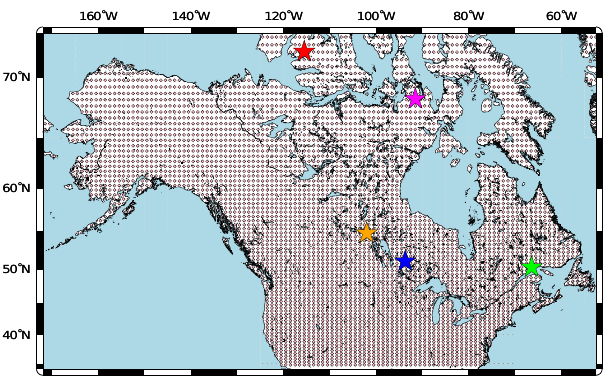
Fig.1. Simulationdomain (172 : 5 o W ; 34 : 75 o N) and (52 : 5 o W ; 75 o N) andgridcelllocationswithintheMUN- Figure 1. Simulation domain (172.5 ◦ W, 34.75 ◦ N and 52.5 ◦ W, GSM. Colored stars mark the locations of the five grid cells from which simulated temperatures are used for 75 ◦ N) and grid cell locations within the MUN-GSM. Colored stars subsequentstudies(see,e.g. Figure2). mark the locations of the five grid cells from which simulated tem- peratures are used for subsequent studies (see, e.g., Fig.